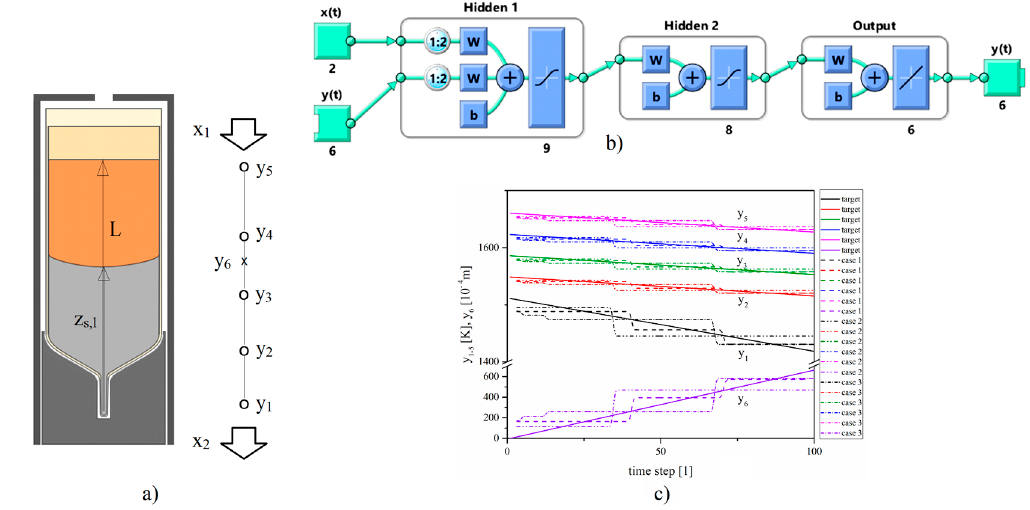
Figure 11. Fast forecasting of dynamic growth recipe in VGF-GaAs growth using NARX-ANN: ( a ) Configuration of the computational domain, ( b ) NARX architecture with 2 hidden layers and 2 time delays, ( c ) predicted temperatures and interface position in monitoring points by an ANN. Reprinted from [28] with permission from Elsevier.